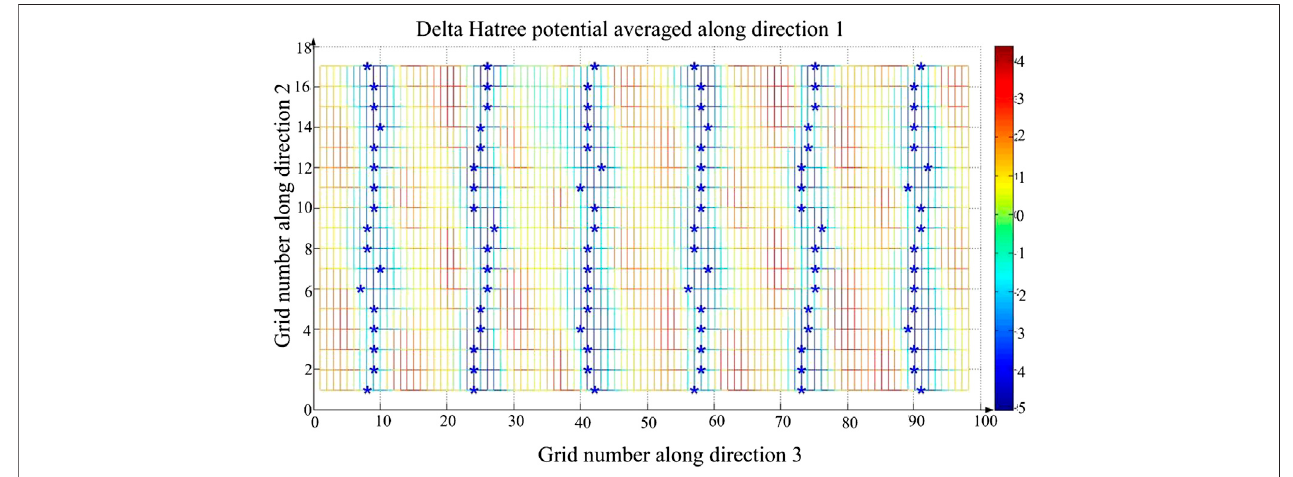
FIGURE 7 | The 2D potential energy map of Li 0.95 Na 0.05 Ni 1/3 Co 1/3 Mn 1/3 O 2 . The blue mark "*" represents the minimum potential energy, sothe electrons will move along the path marked blue